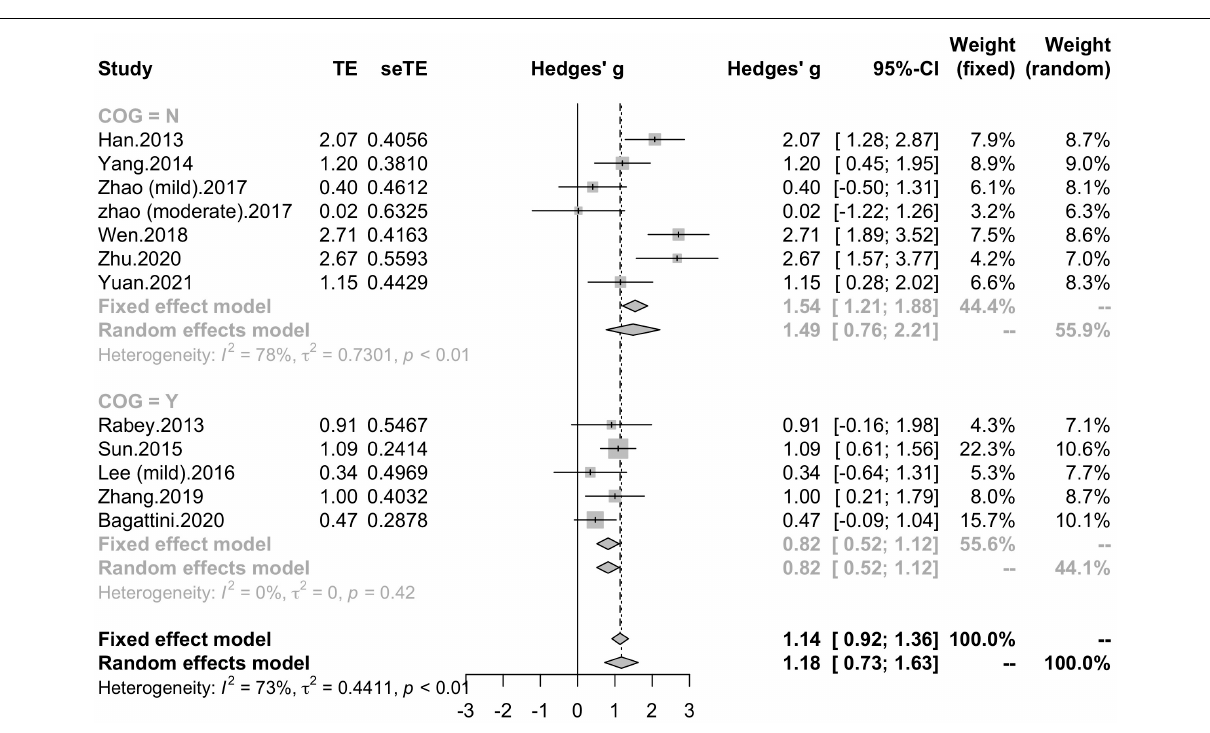
FIGURE 7 | Forest plot: mean differences in cognitive training subgroups with 95% CI. COG, cognitive training.